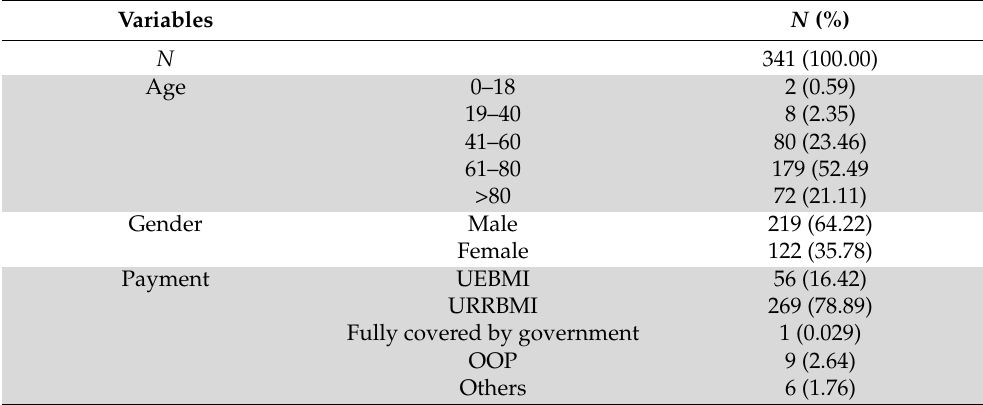
Table 8. Characteristics of the included heart failure patients ( N =